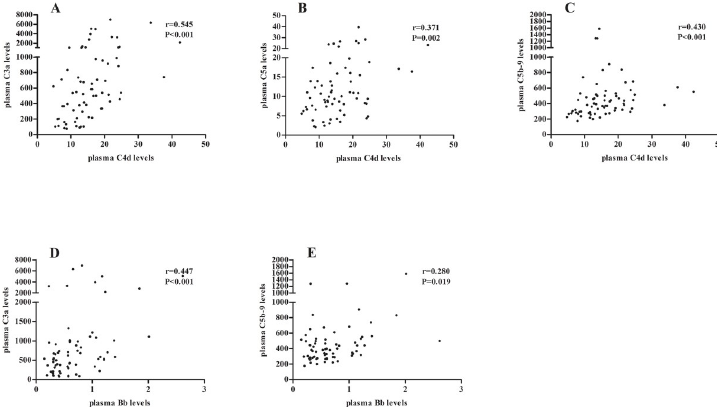
Fig 3. Correlations of plasma complement components in each patient. Plasma level of C4d was positively correlated with that of C3a (A), C5a (B) and C5b-9 (C). Plasma level of Bb was positively correlated with that of C3a (D) and C5b-9 (E).